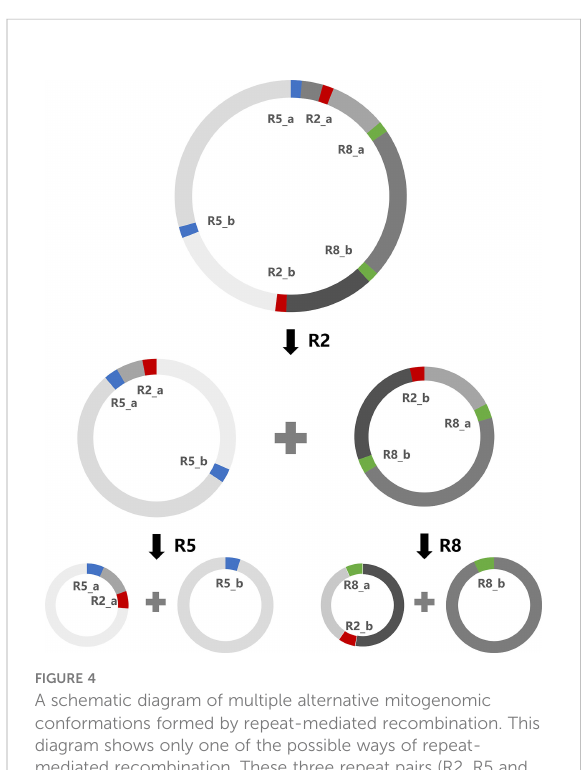
FIGURE 4 A schematic diagram of multiple alternative mitogenomic conformations formed by repeat-mediated recombination. This diagram shows only one of the possible ways of repeat- mediated recombination. These three repeat pairs (R2, R5 and R8) in the A. indica mitogenome are direct